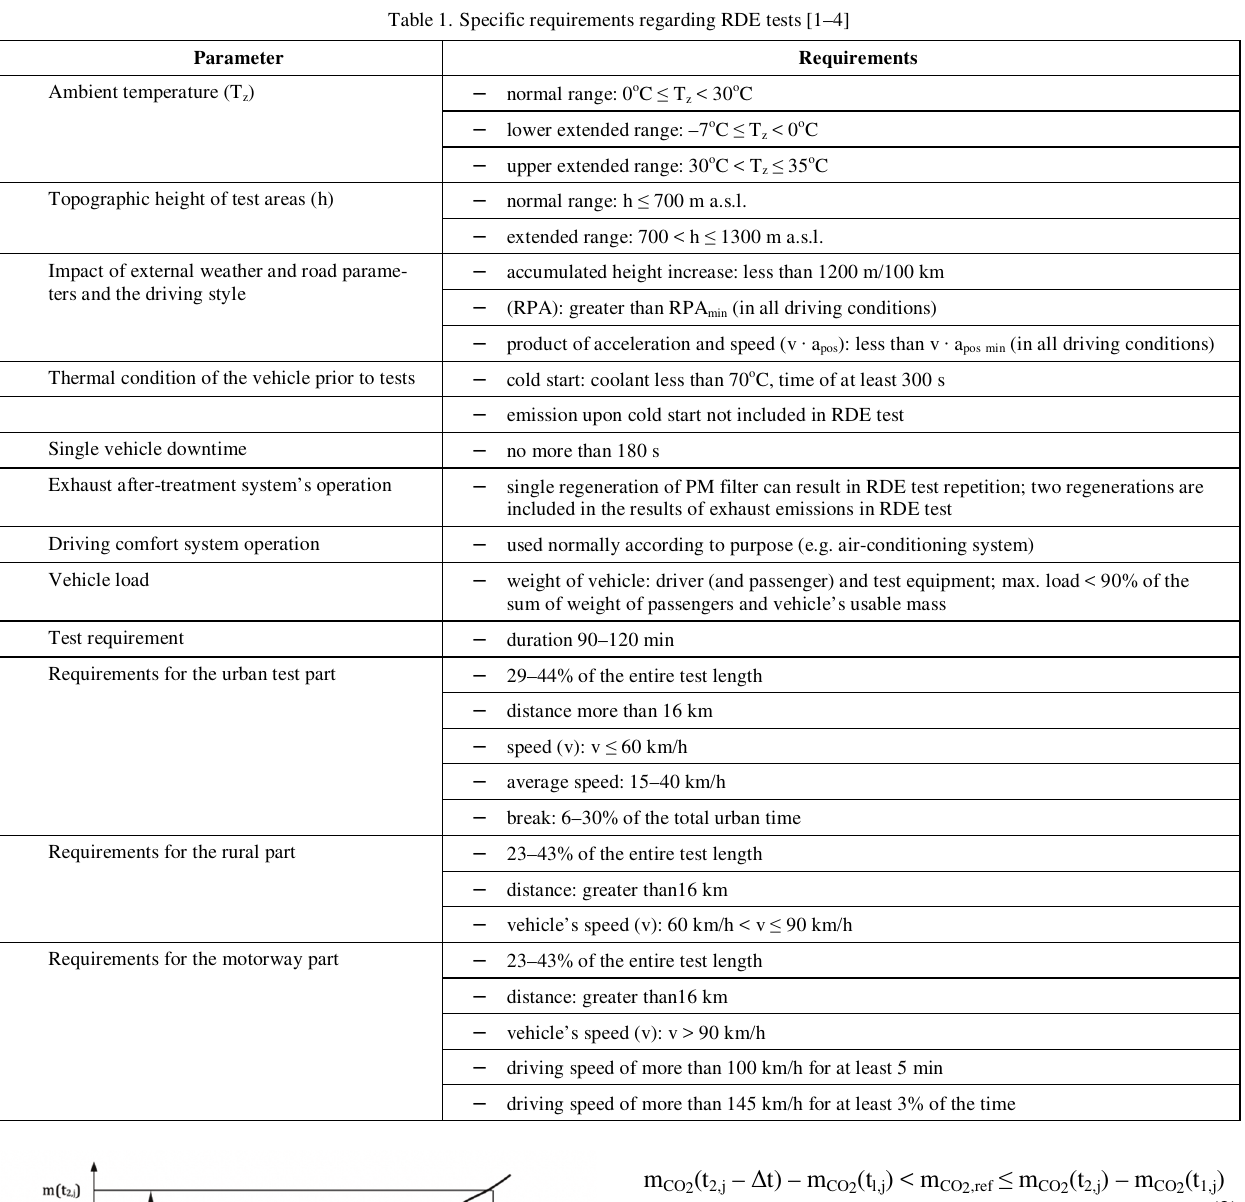
Table 1. Specific requirements regarding RDE tests